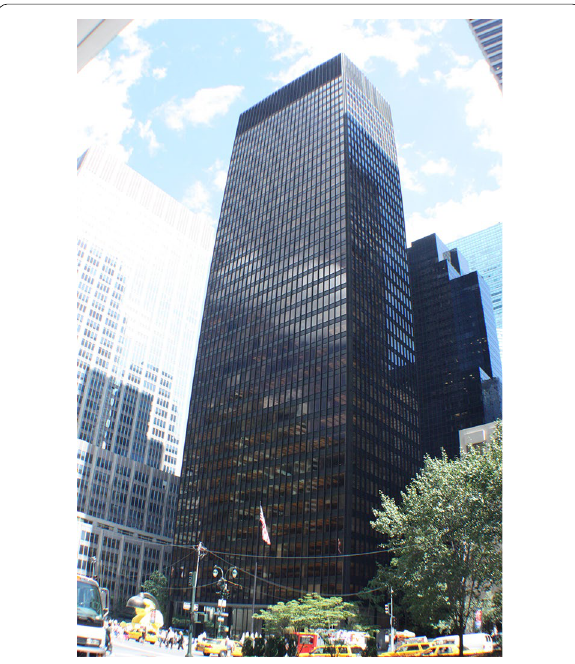
Fig. 9 The entrance to the Fuller Building shows the New York skyline and portraits of workers